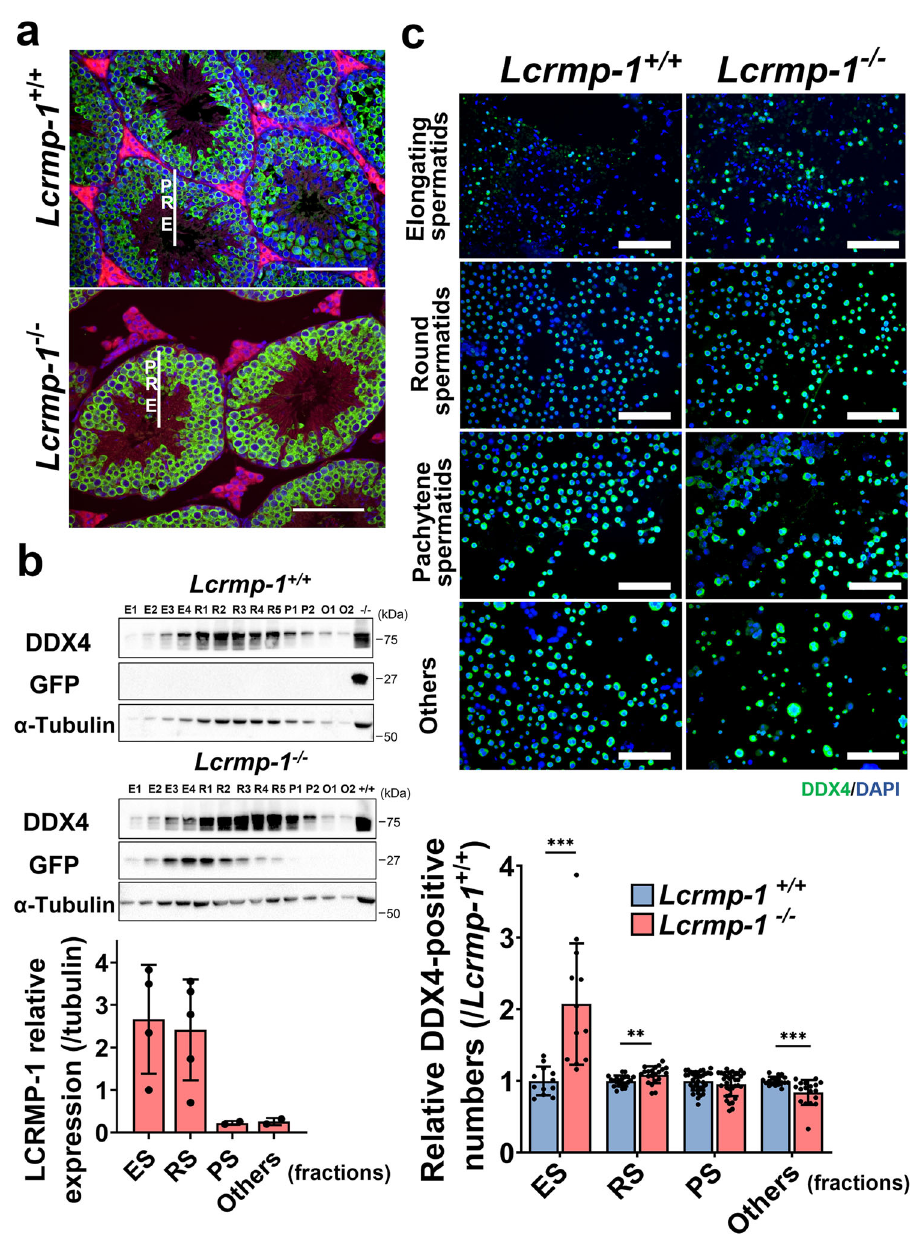
Fig. 4 De fi ciency of LCRMP-1 mainly expressed in spermatids causes DDX4-positive cells accumulation in the adluminal compartment. a DDX4 expression pattern in the seminiferous tubules, as revealed by immuno fl uorescence staining. Blue, green, and red signals represent the nucleus, DDX4, and phalloidin (F-actin), respectively. P, pachytene spermatocytes; R, round spermatids, E, elongating spermatids. Scale bars, 100 μ m. b Expression pro fi ling of LCRMP-1 and DDX4 in fractionated testicular cells from seminiferous tubules. The testicular cells were isolated from the seminiferous tubules in the testes followed by BSA density-gradient fractionation. In total, 28 fractions were collected and 10% of the volume of each fraction was loaded for Western blotting. E1 – E4, R1 – R5, P1 – P2, and O1 – O2 represent corresponding elongating spermatids (fractions 1 – 4), round spermatids (fractions 5 – 11), pachytene spermatocytes (fractions 12 – 22), and others (fractions 23 – 28), respectively. We quanti fi ed GFP as an indicator to calculate the relative expression of LCRMP-1, normalized to E1. c Immuno fl uorescence staining of testicular cells from each cell fraction. Blue and green signals represent the nucleus and DDX4, respectively. The fl uorescence positive signal ratio was measured using ImageJ. The ratio was calculated as the total number of Alexa Fluor 488 Dye-positive cells divided by the total number of DAPI-positive cells. Each cell fraction was analyzed in biological triplicate ( n = 3, mean ± SD, two-tailed Student ’ s t -test, **<0.01; *** p < 0.001). ES elongating spermatids, RS round spermatids, PS pachytene spermatocytes part. Scale bars, 100 μ